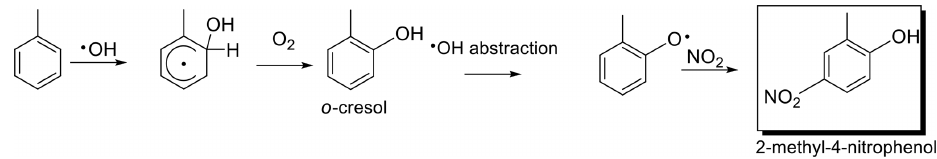
Figure 1. Proposed formation mechanism of 2-methyl-4-nitrophenol from toluene oxidation (adapted from Forstner et al.,